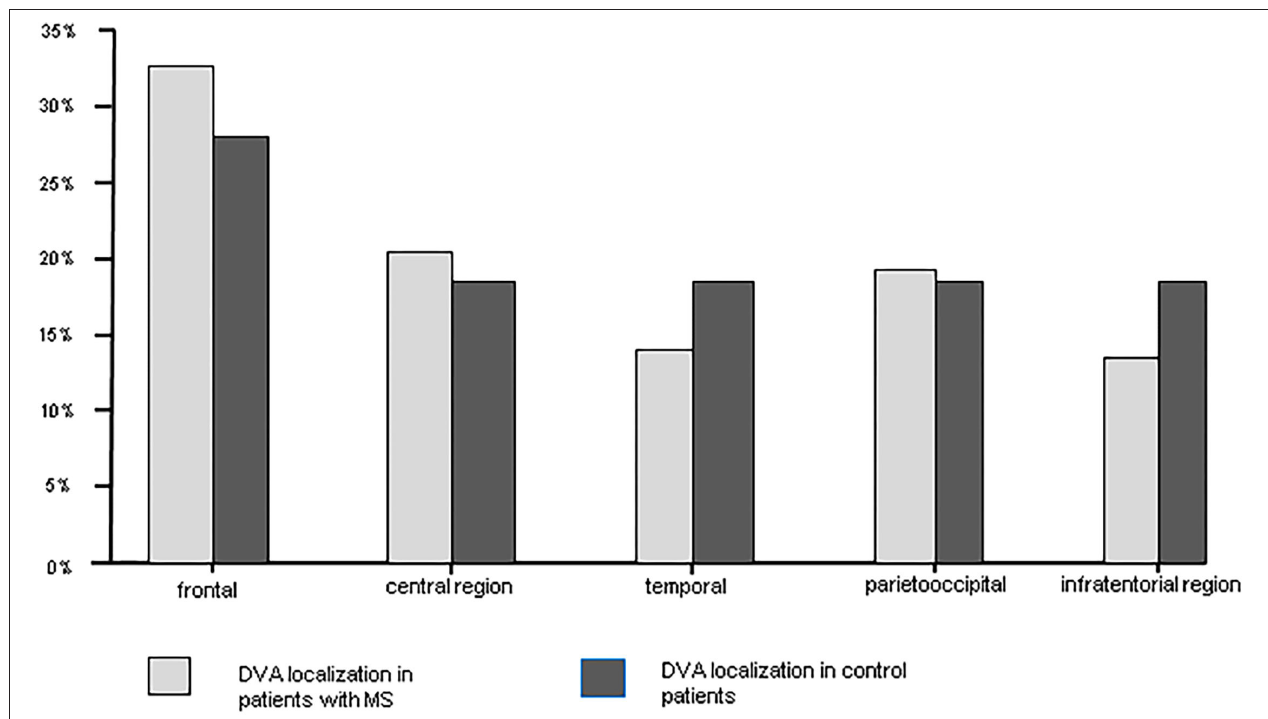
FIGURE 1 | DVA localization in patients with MS and in control patients.